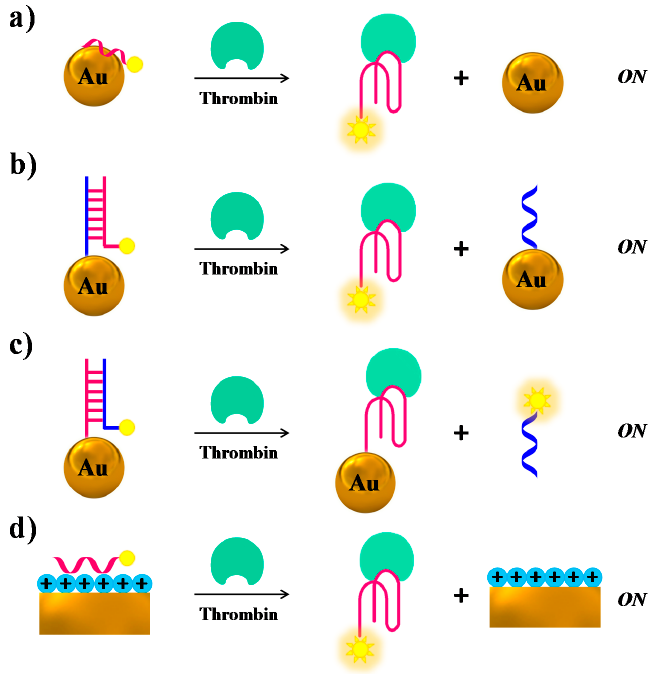
Figure 9. Schematic representation of thrombin detection by fluorescence strategies based on